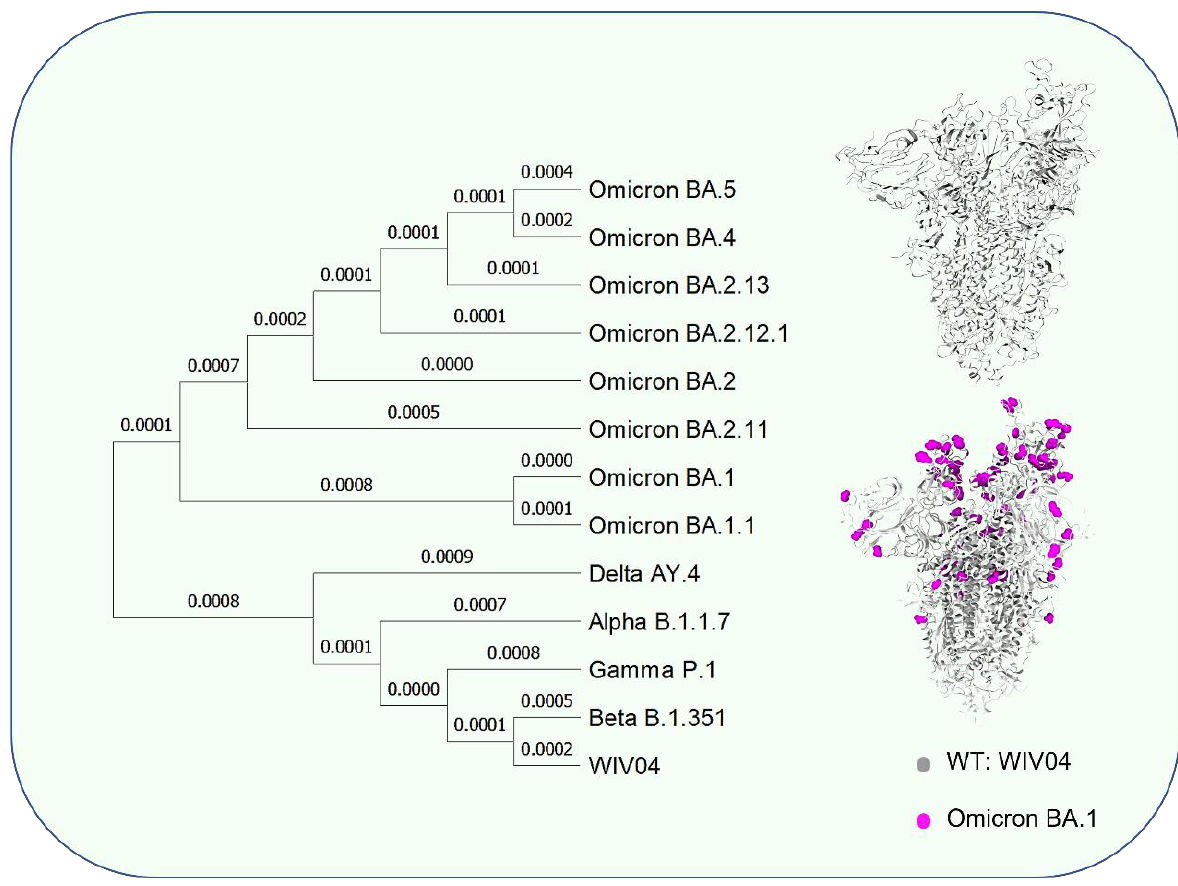
Figure 1. Phylogenetic tree using neighbor-joining method and schematic diagram of mutation sites. Phylogenetic tree was generated by MEGAsoftware(version 11.0.13). The genomes of CoV variants were retrieved from GISAID (https:// www.gisaid.org/, accessed on 2 November 2022). WIV04: